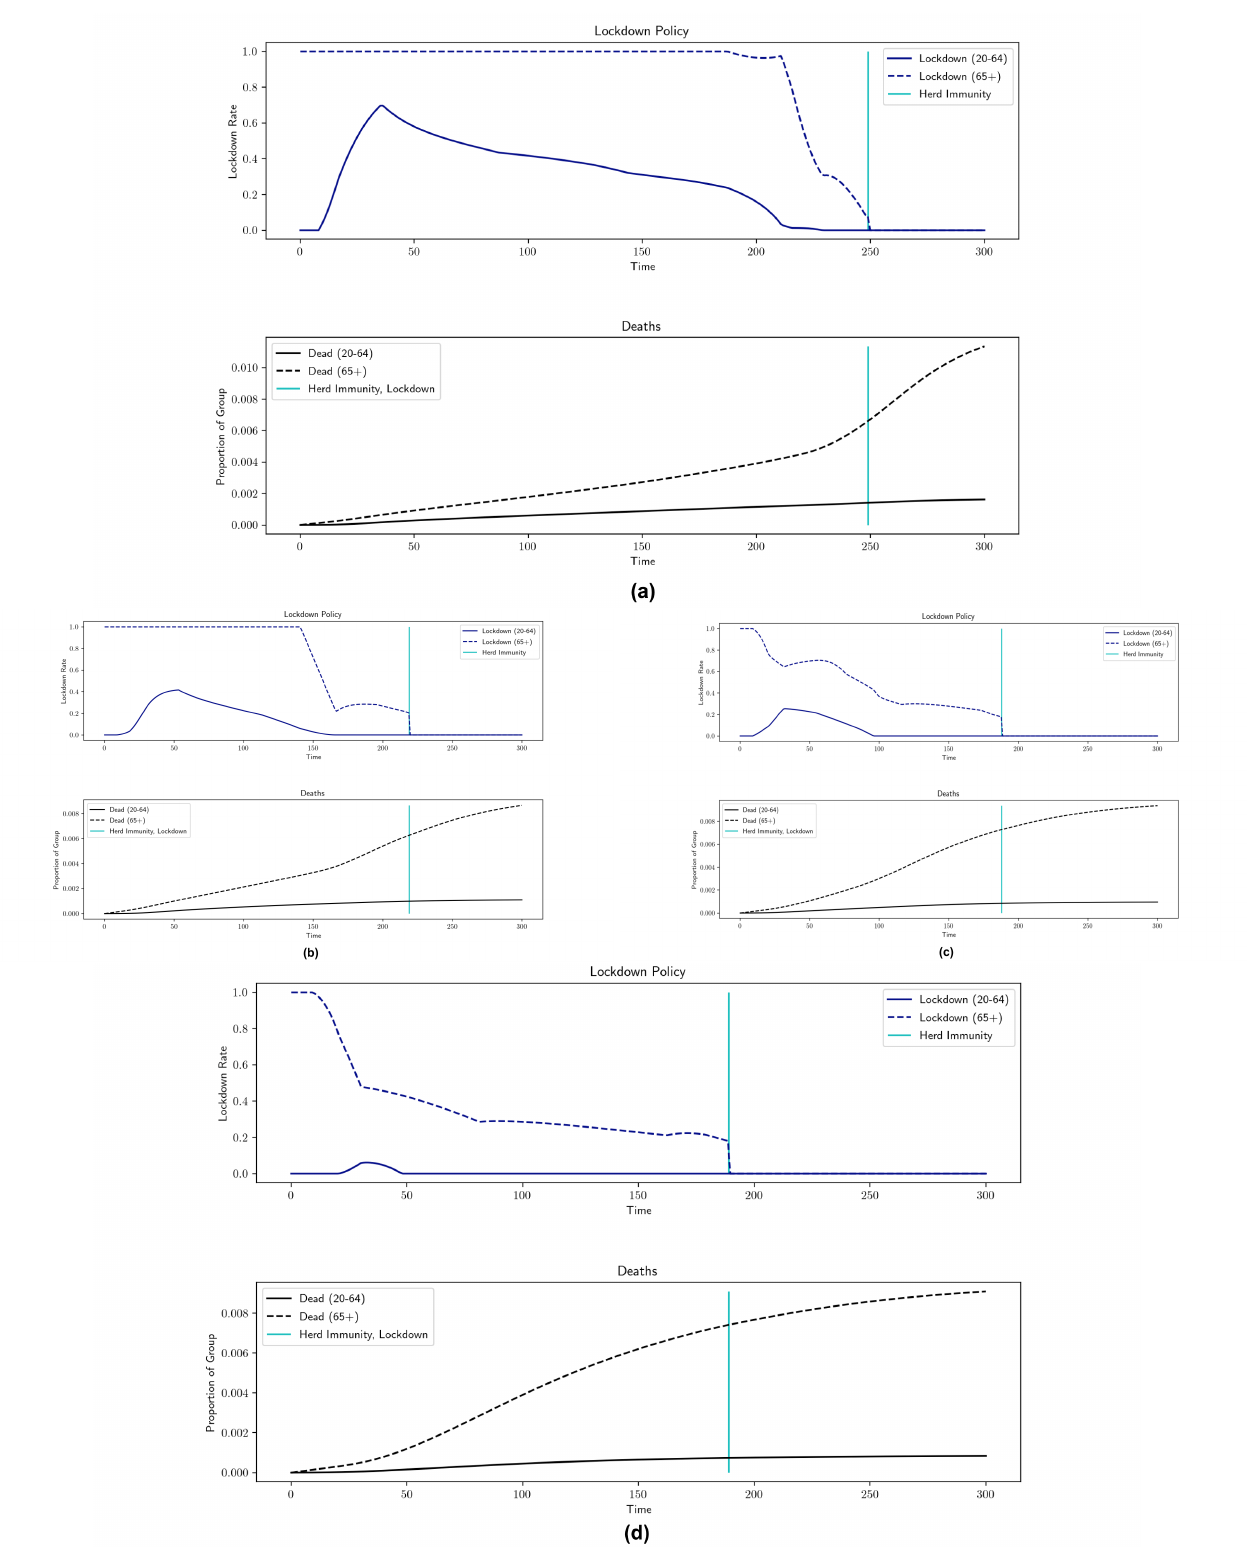
Figure 10. Robustness results for α I (scale factor for individual carefulness in response to current levels of infection). ρ = 0.75, χ = 10/ r , r = 0.001%, ν = 0.67, α L = 10 − 5 , α E = 0.42, η = 10, F = 1, h = 0.4. ( a ) α I = 0, lockdown: 249 d, output loss: 10.6699%, total deaths: 0.3712%; ( b ) α I = 6, lockdown: 219 d, output loss: 4.5236%, total deaths: 0.2651%; ( c ) α I = 8, lockdown: 188 d, output loss: 1.9019%, total deaths: 0.259%; ( d ) α I = 10, lockdown: 189 d, output loss = 0.1558%, total deaths =